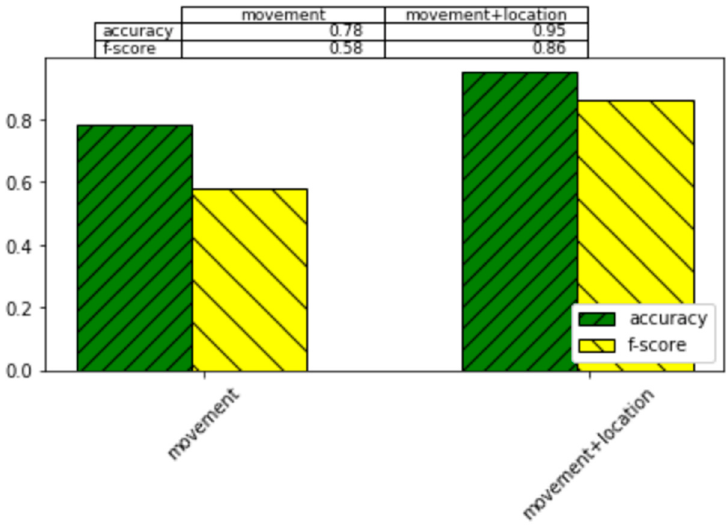
Figure 9. Activity recognition performance for 66 subjects based on 3-fold cross validation. Accuracy and macro f-score performance are reported for movement sensors, location sensors, and all sensors.